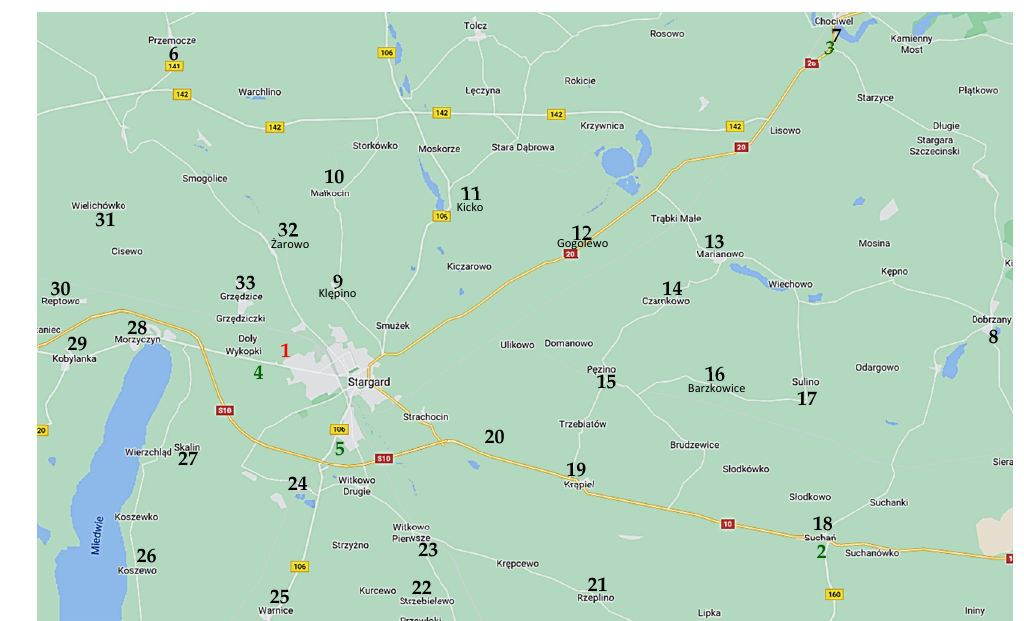
Figure 4. Deployment of the depot (1), charging stations (2–5) and customers (6–33). The listed points are actual locations on the map. The city of Stargard is the largest town in the area and is the base for many delivery companies. Charging stations have been proposed at points that are located on important routes and are easily